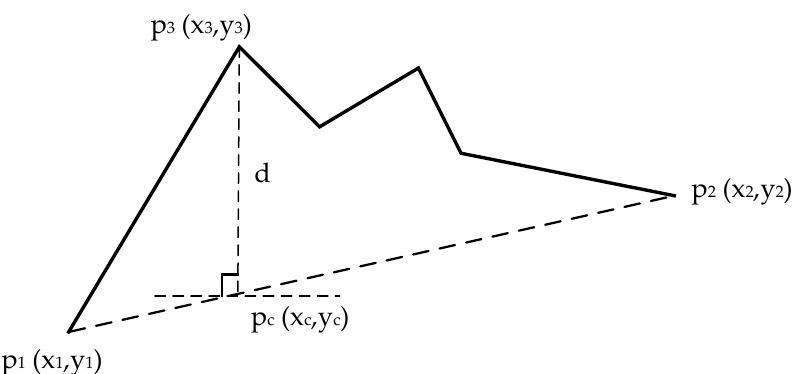
Figure 2. Capturing sequence fluctuations by measuring vertical distance.